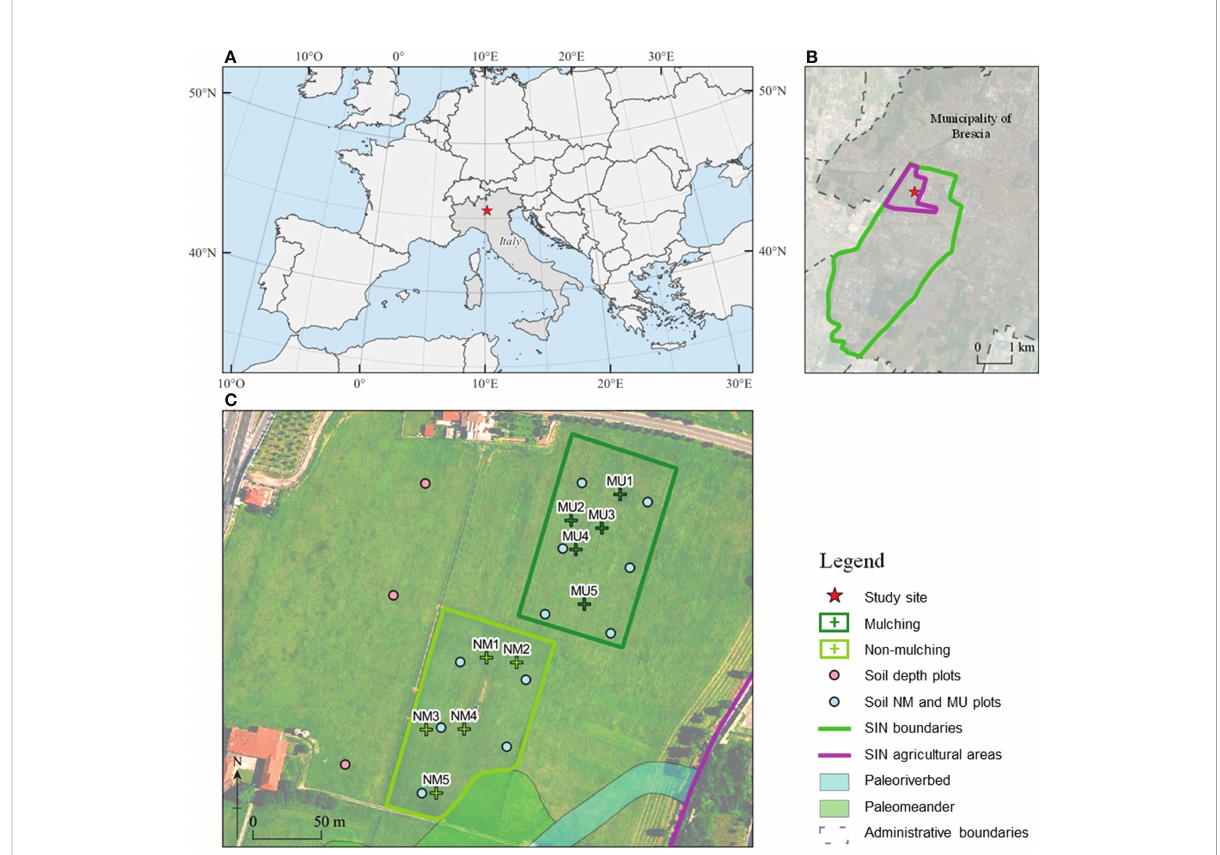
FIGURE 1 Location of the National Relevance Site (SIN) Brescia-Caffaro in Northern Italy (A) with a detail of the contaminated agricultural areas (B) , and of the control (NM; no mulching) and mulching-treated (MU) areas sampled within the study site (C) . Crosses indicates the location of the vegetation sampling points, and circles indicate the location of the soil sampling points: pink, soil sampled each 10 cm layer up to 100 cm depth in 2014, light blue, mixed homogeneous soil sampled up to 40 cm in 2014 and